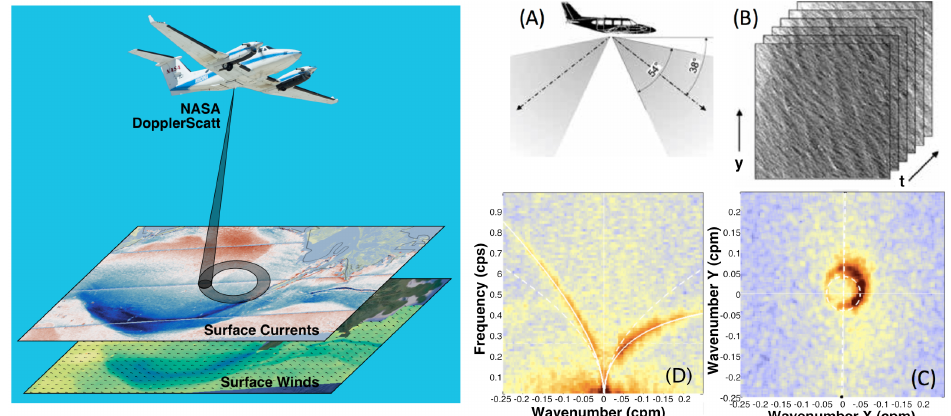
Figure 1. (left) DopplerScatt measurement geometry and example surface current and wind data products. (right) ROCIS measurement concept: ( A ) camera viewing geometry; ( B ) sample wave time series captured by camera; ( C ) 2D spatial spectrum slice; ( D ) space-time spectrum slice showing wave dispersion shift due to surface